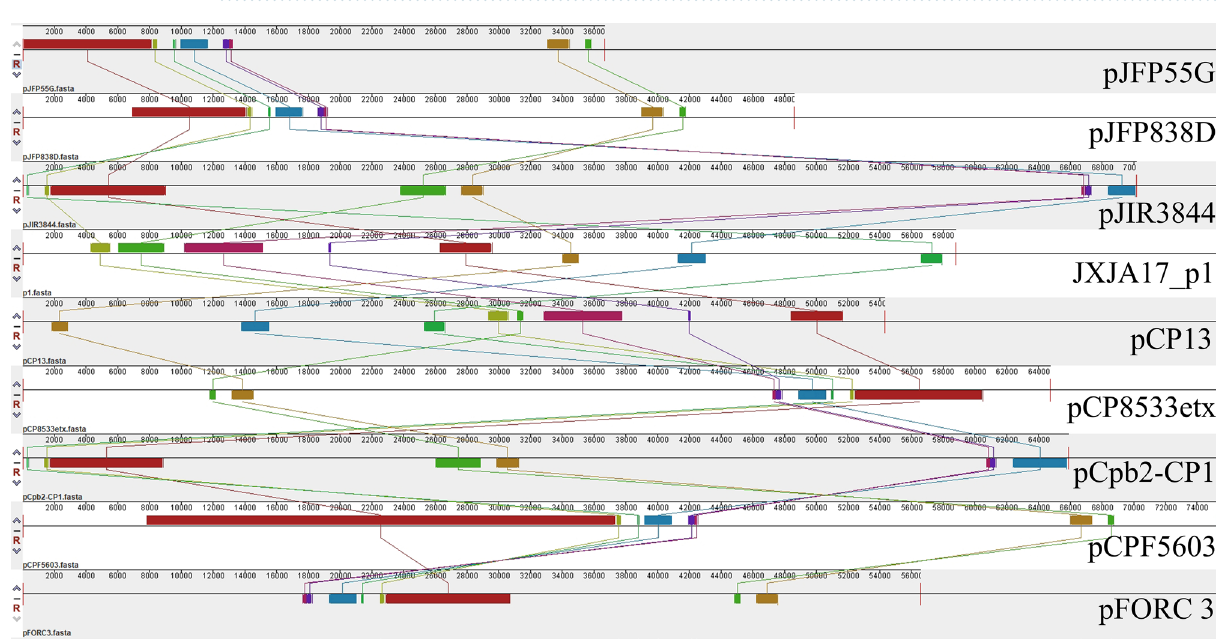
Figure 4. Collinearity analyses of plasmids JXJA17_p1, pFORC3, pJFP55G, pJFP838D, pJIR3844, pCpb2-CP1, pCP8533etx, pCP13, and pCPF5603. Results aligned by using Mauve 2.4.0. (http://darli nglab .org/mauve